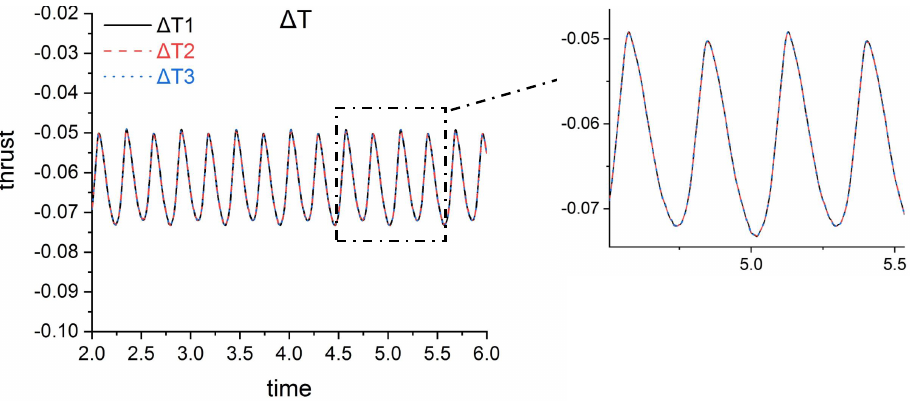
Figure 3. Result of grid-independence analysis.